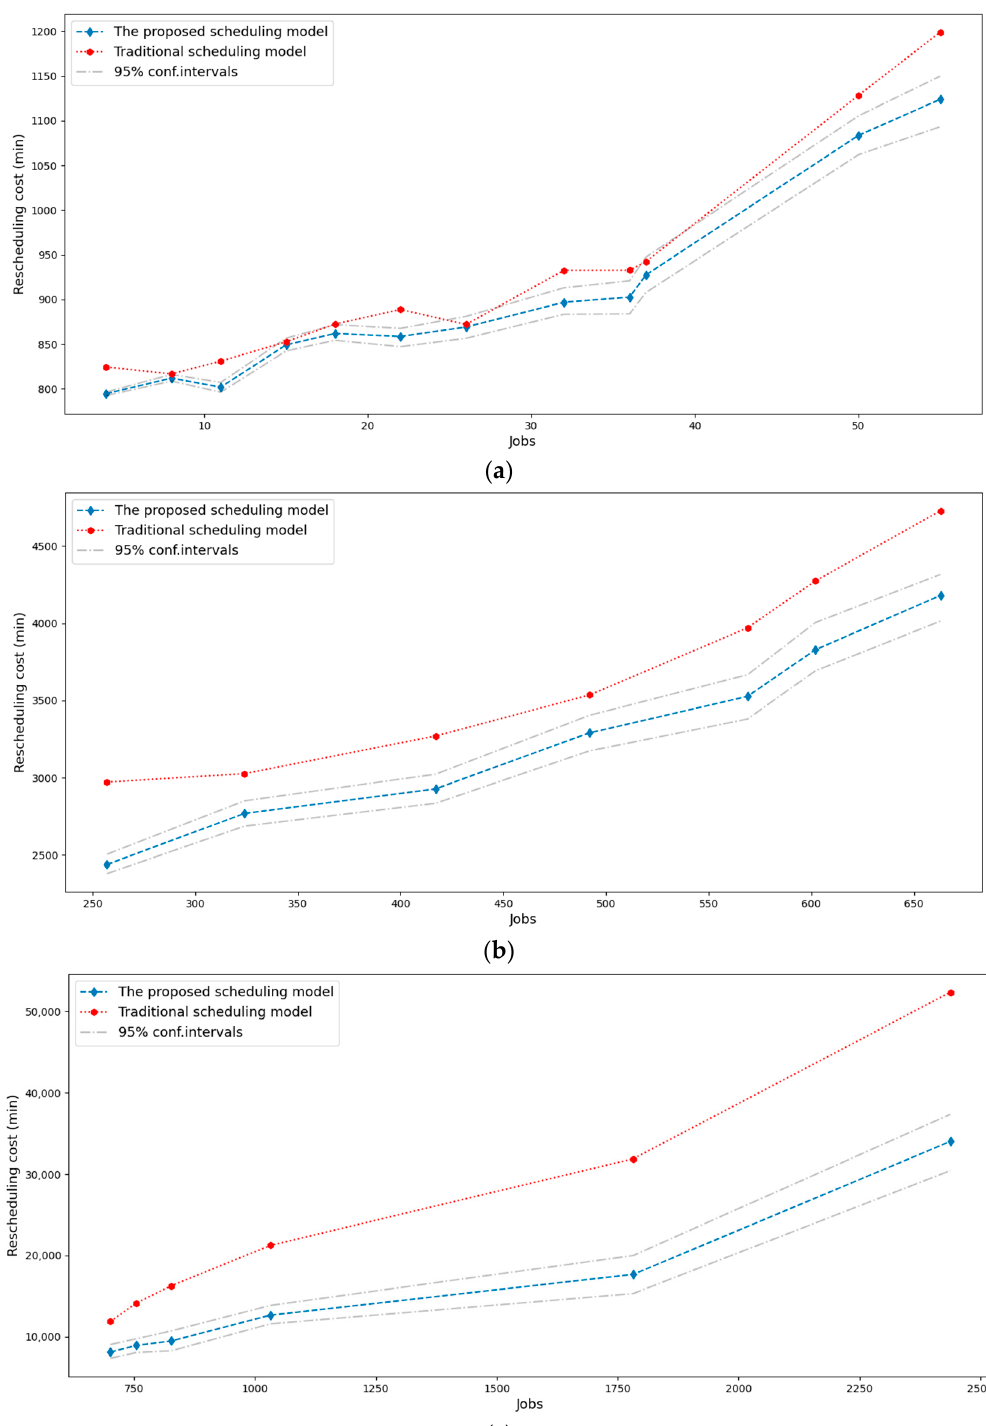
Figure 3. Comparison of experimental results. ( a ) Comparison of small-scale problems; ( b ) comparison of medium-scale problems; ( c ) comparison of large-scale problem. The experimental parameter data are shown in the Appendix A. For